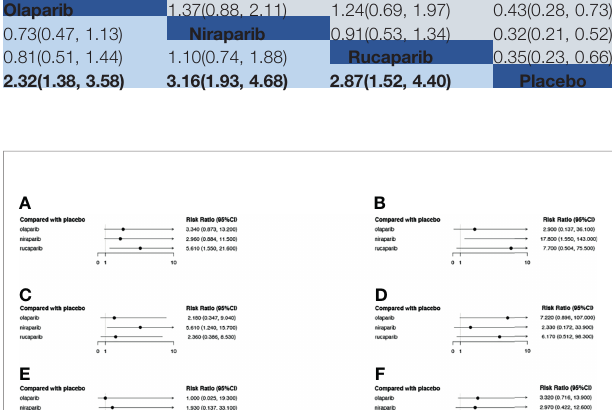
TABLE 7 | The network meta-analysis of grade 3-4 AEs in the maintenance phase. Olaparib